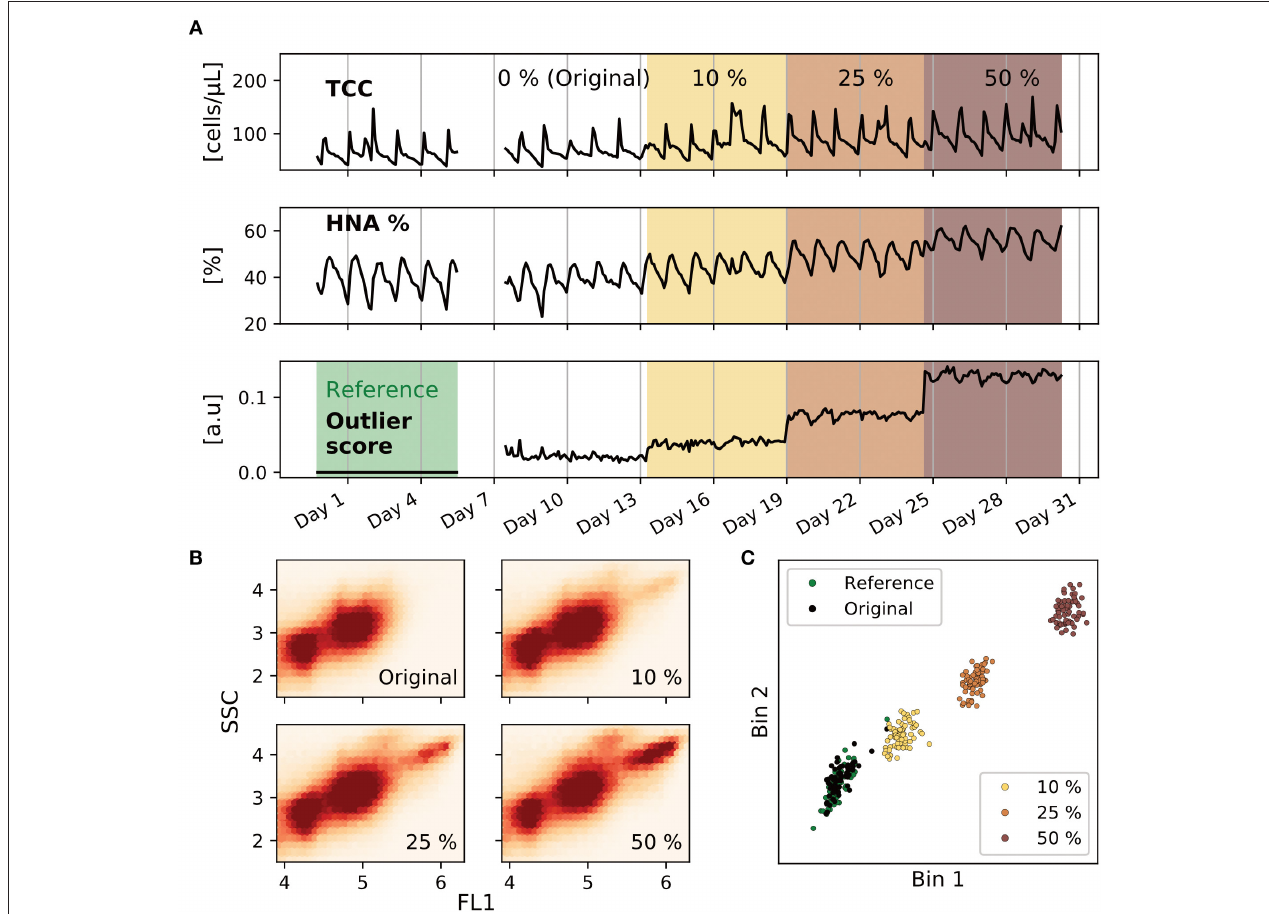
FIGURE 3 | Model testing in a numerical experiment. Data from an original flow cytometric time series was gradually contaminated in-silico with data from pathogenic bacteria. (A) Cell concentration, high nucleic acid (HNA) percentage and outlier score are presented for the entire time series. The time series was divided into five partitions: reference data, original data (0%), spiking at 10, 25, and 50%. (B) Density maps of partitions 2–5 in the flow cytometric signal space, estimated on an aggregate of all measurements in the partition. A darker color corresponds to a higher density. (C) Two-dimensional projection of the fingerprints calculated by the PB algorithm. These two dimensions correspond to the bins that allow to discriminate the most between the original and contaminated measurements (highest ANOVA F -value). One dot corresponds to one FCM measurement, and all the measurements from the displayed time series are plotted. The original measurements (black) overlap with those from the reference set (green), but the spiked measurements (orange, red and dark red for 10, 25, and 50%, respectively) are increasingly far from the reference set